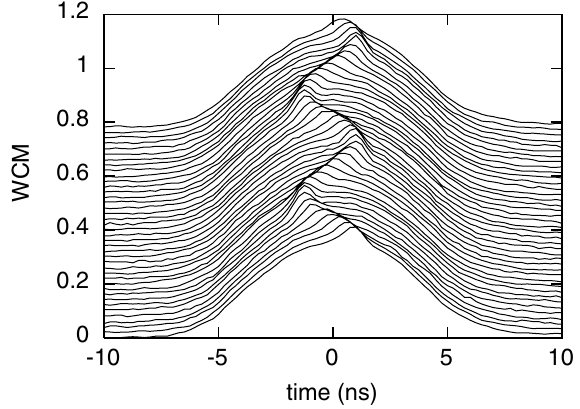
FIG. 5. Wall current monitor data for a different bunch at